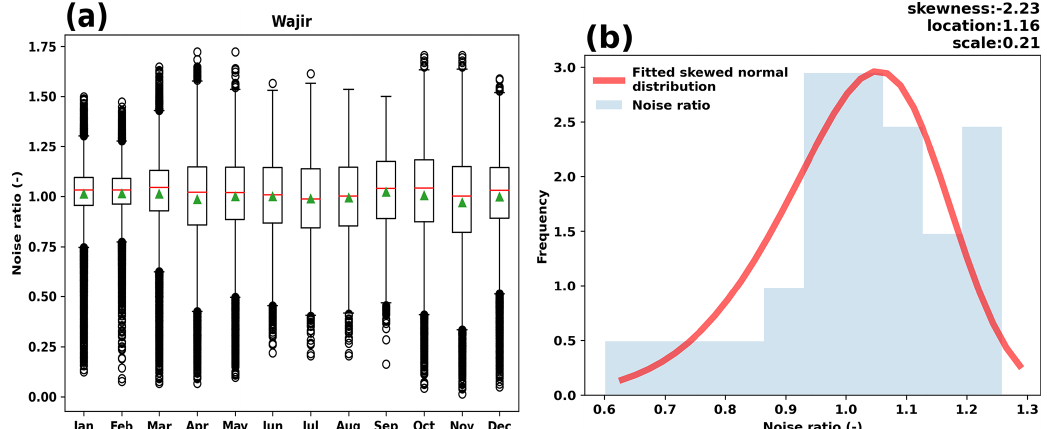
Figure 4. (a) Noise ratio box plot for a single location in Wajir (Kenya). The box plots indicate that the noise ratio is variable over each month, with the green triangle showing the mean, and the red line in the box plot indicating the median. (b) A histogram for the January noise ratio is shown in blue shaded bars, with the fitted skewed normal distribution shown as a red solid line. The corresponding distribution parameters are indicated in the top left of the plot.